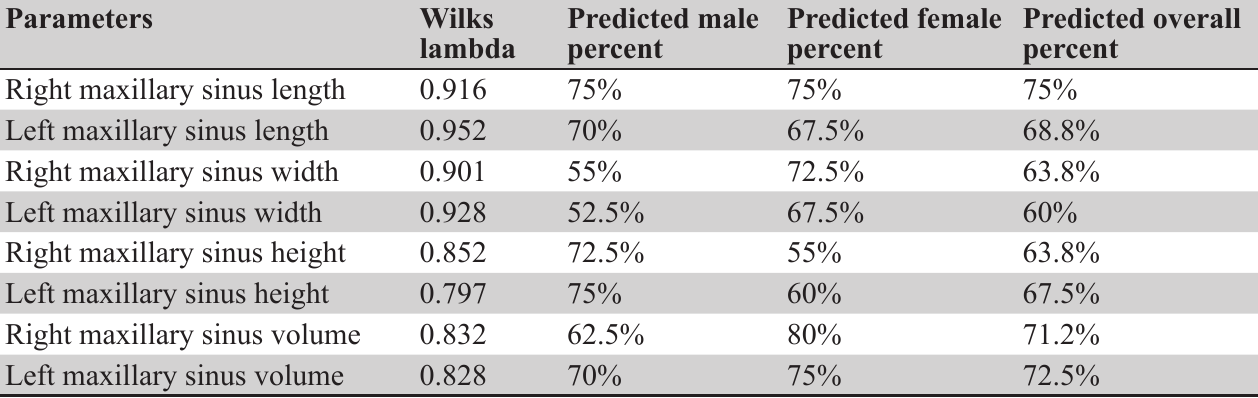
Table 3. Discriminant analysis using right or left maxillary sinus measurement to distinguish between males and females Parameters